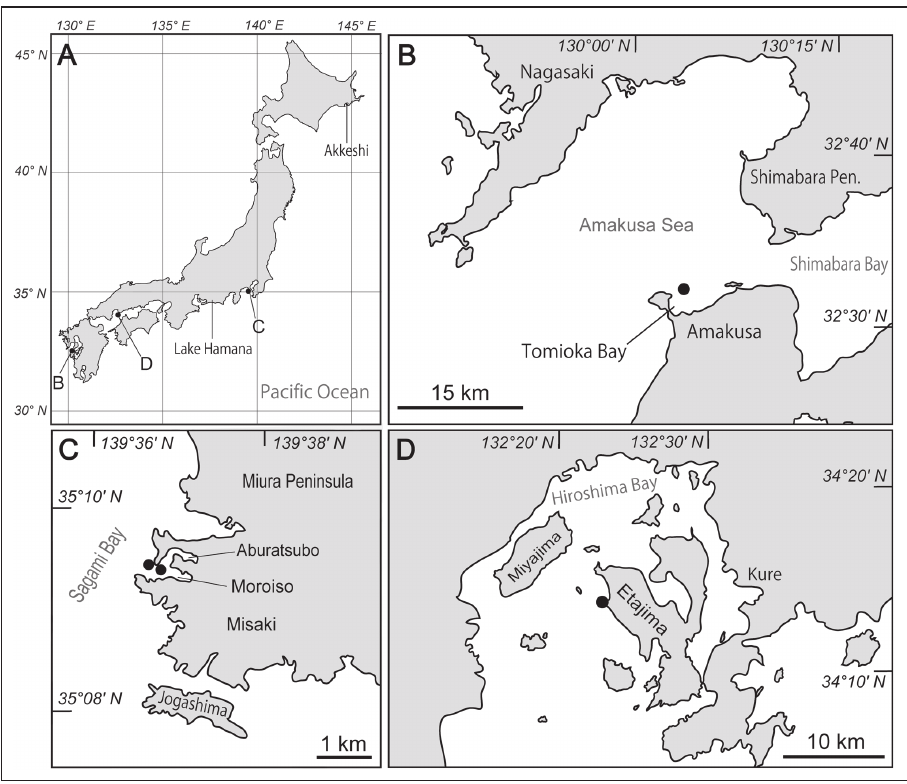
and the locations of Lake Hamana and Akkeshi B enlargement of west-central Kyushu, with the solid circle indicating the collecting site at Amakusa C enlargement of the southwestern part of the Miura Peninsula, with solid circles indicating the topotype collecting sites (type localities) of P. ijimai Oka, 1897 at Misaki, Sagami Bay D enlargement of Hiroshima Bay, with the solid circle indicating an additional collecting site for P. ijimai at